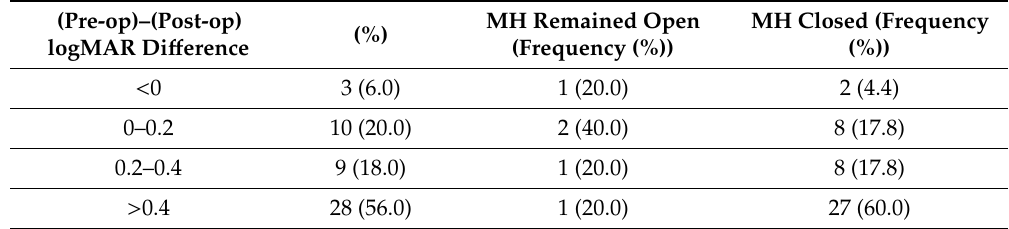
Table 4. Distribution of patients according to the improvement in visual acuity and duration of the symptoms and closure status of the MH .